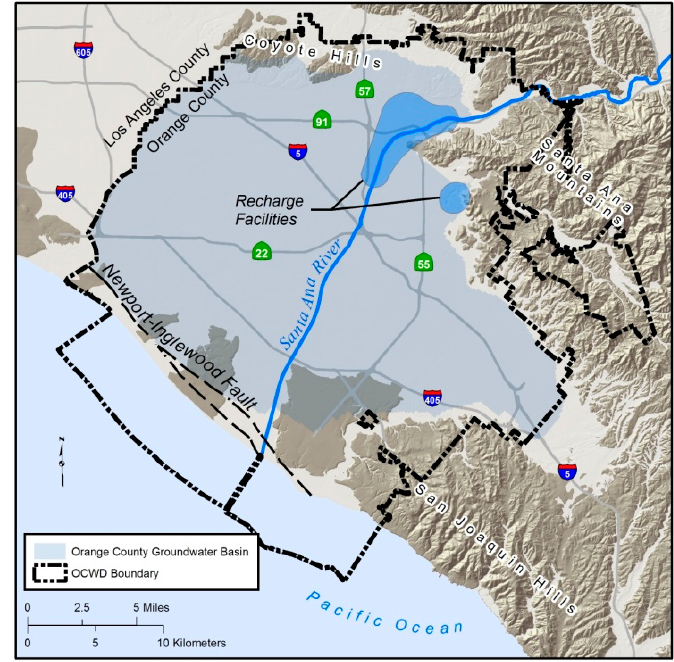
Figure 1. The Orange County Water District recharges the basin with Santa Ana River water, recycled water, and imported water at 400 ha (1000 acre) of infiltration ponds.